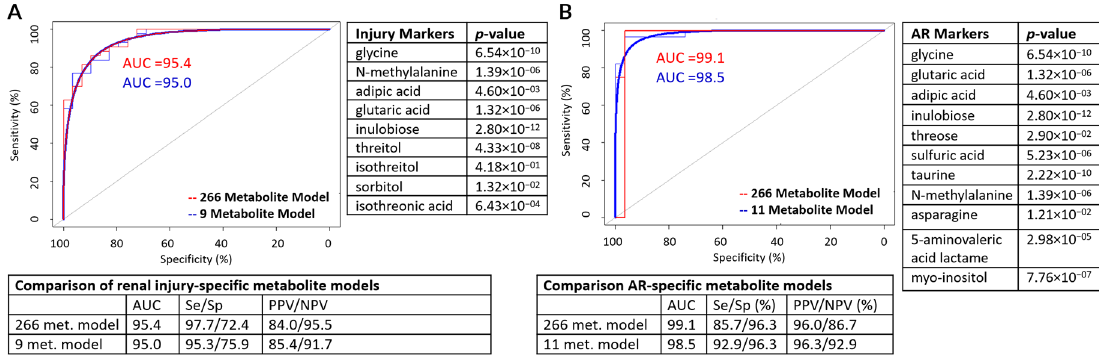
Figure 3. Identification of potential biomarker panel of metabolites for KTx alloimmune injury and acute rejection using VSURF method. ( A ) Two receiver operating characteristic (ROC) curves representing classification accuracies and a statistical comparison of the full and sparse RF models for alloimmune injury and the table displaying classification accuracy on the test set. The metabolites in the panel are listed on the right-hand side ( B ) Two ROC curves representing classification accuracies and a statistical comparison of the full and sparse Random Forests (RF) models for acute rejection (AR) injury and the bottom table displaying classification accuracy on the test set. The metabolites in the panel are listed on the right-hand side.